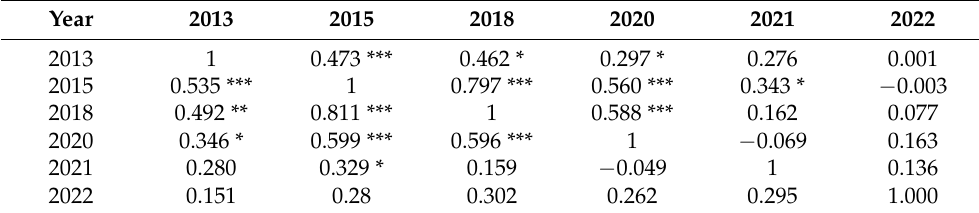
Table 4. Pearson product moment and Spearman’s rank correlation coefficients (above and below the diagonal) among clone mean cone production across years.